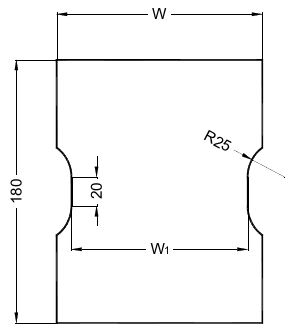
Figure 5. Drawing of the test tooling in mm.